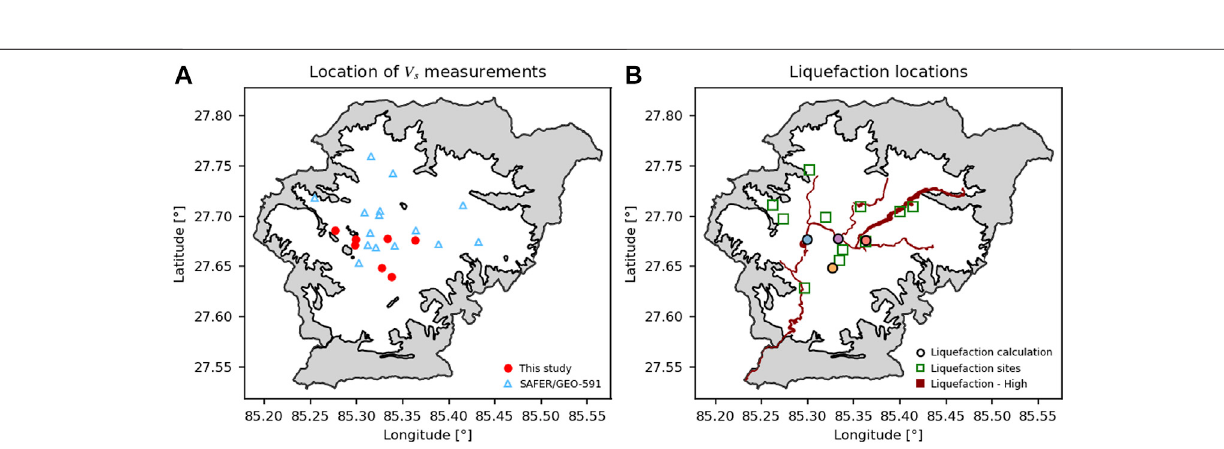
Frontiers in Built Environment |